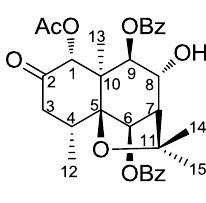
Figure 1. Structure of the natural sesquiterpene 1 from P.